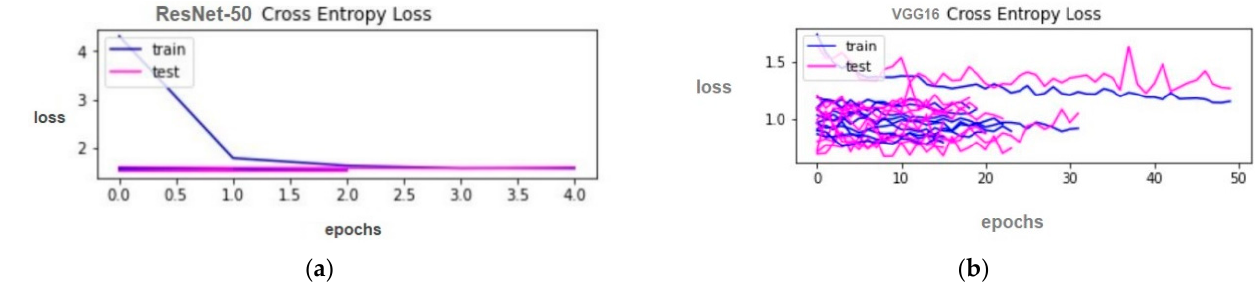
Figure 5. ResNet-50 and VGG16 Cross entropy loss. Figure 5. ( a ) ResNet-50 cross entropy loss for training set and test set; ( b ) VGG16 cross entropy loss for training set and test set.